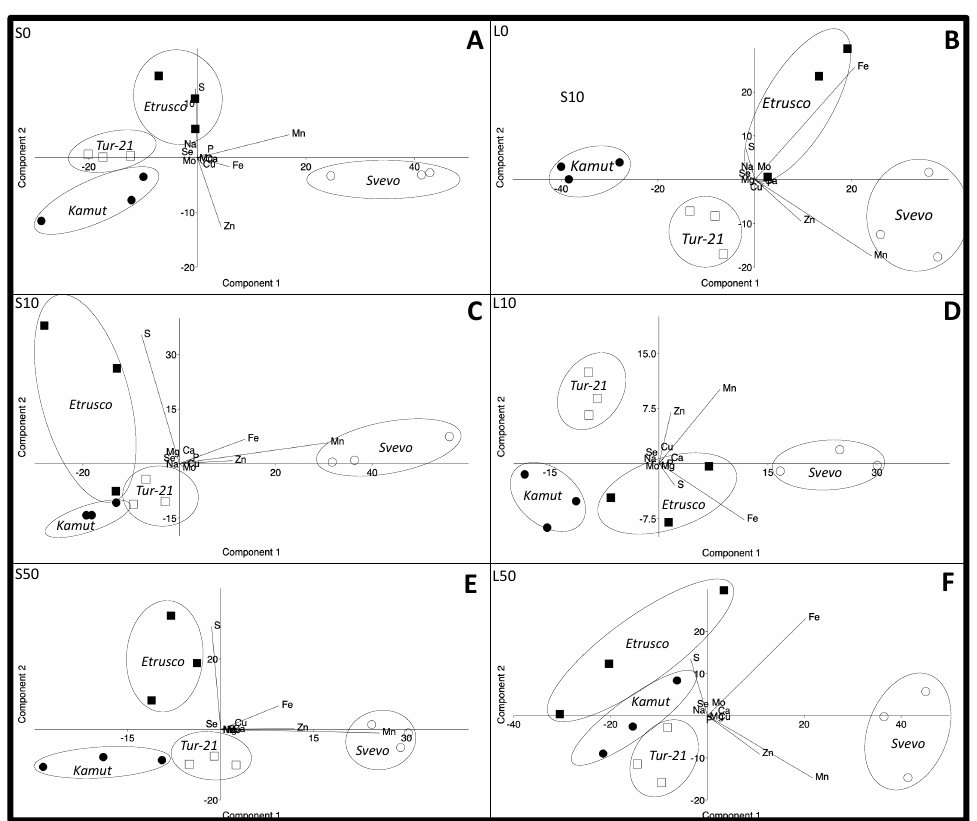
Figure 4. Principal component analysis (PCA) to reveal changes within the ionome of plant shoots. Principal component analysis (PCA) scatter plot of the shoot ionome of four wheat genotypes (Svevo, Tur-21, Kamut, and Etrusco). Plants were grown while exposed to different sulfate levels (S and L, 1.2 and 0.06 mM sulfate, respectively) and three different Se levels (0, 10, and 50 mM), provided as selenate. ( A ): S0 condition, ( B ): L0 condition, ( C ): S10 condition, ( D ): L10 condition, ( E ): S50 condition, ( F ): L50 condition.